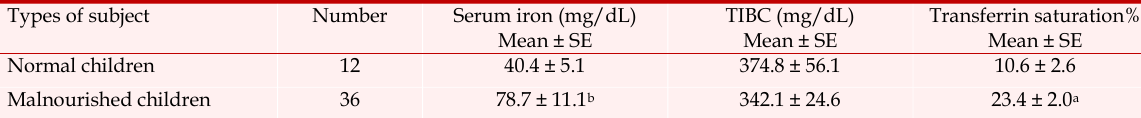
shown in Table III. The mean serum iron and transferrin saturation level were (78.7 ± 11.1 µg/dL, 23.4 ± 2.0%) significantly high (p<0.001) in malnourished